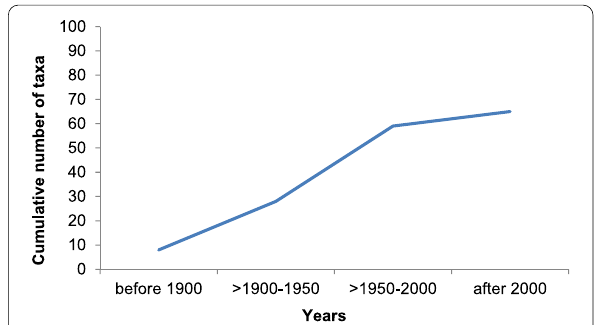
Fig. 2 Temporal distribution pattern of Ponto‑Caspian invertebrate AIS taxa that have established outside of the P‑C region over time (based on available data of the respective first record of each in a non‑native region, according to GBIF)